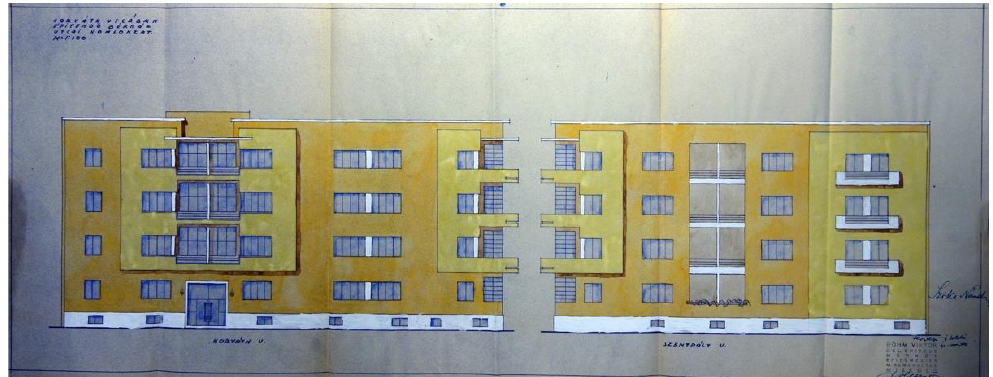
Figure 17. Lajos Horv á th street and Szentp á li corner, Miskolc, tenement house (unrealised). Architect: Victor Bohm, 1938. Source: MNL BAZML IV. 1906. 22043/1938